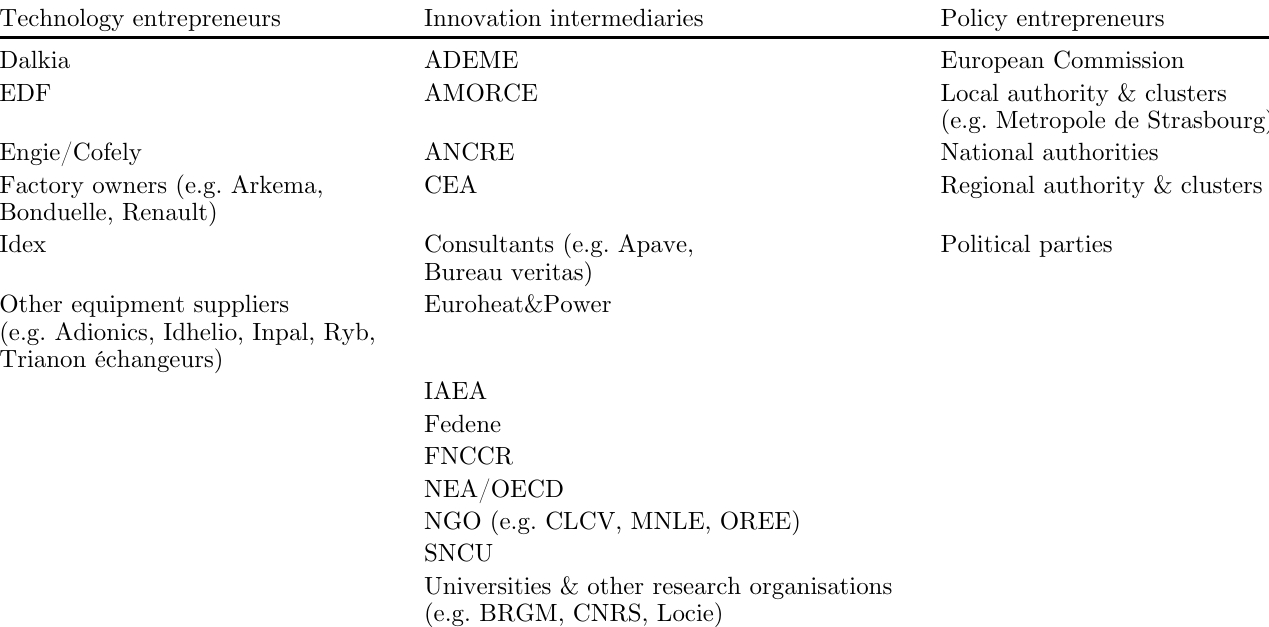
Table 1. Actors that could be involved in the revolt and remember processes surrounding the development of heat production with nuclear plants in